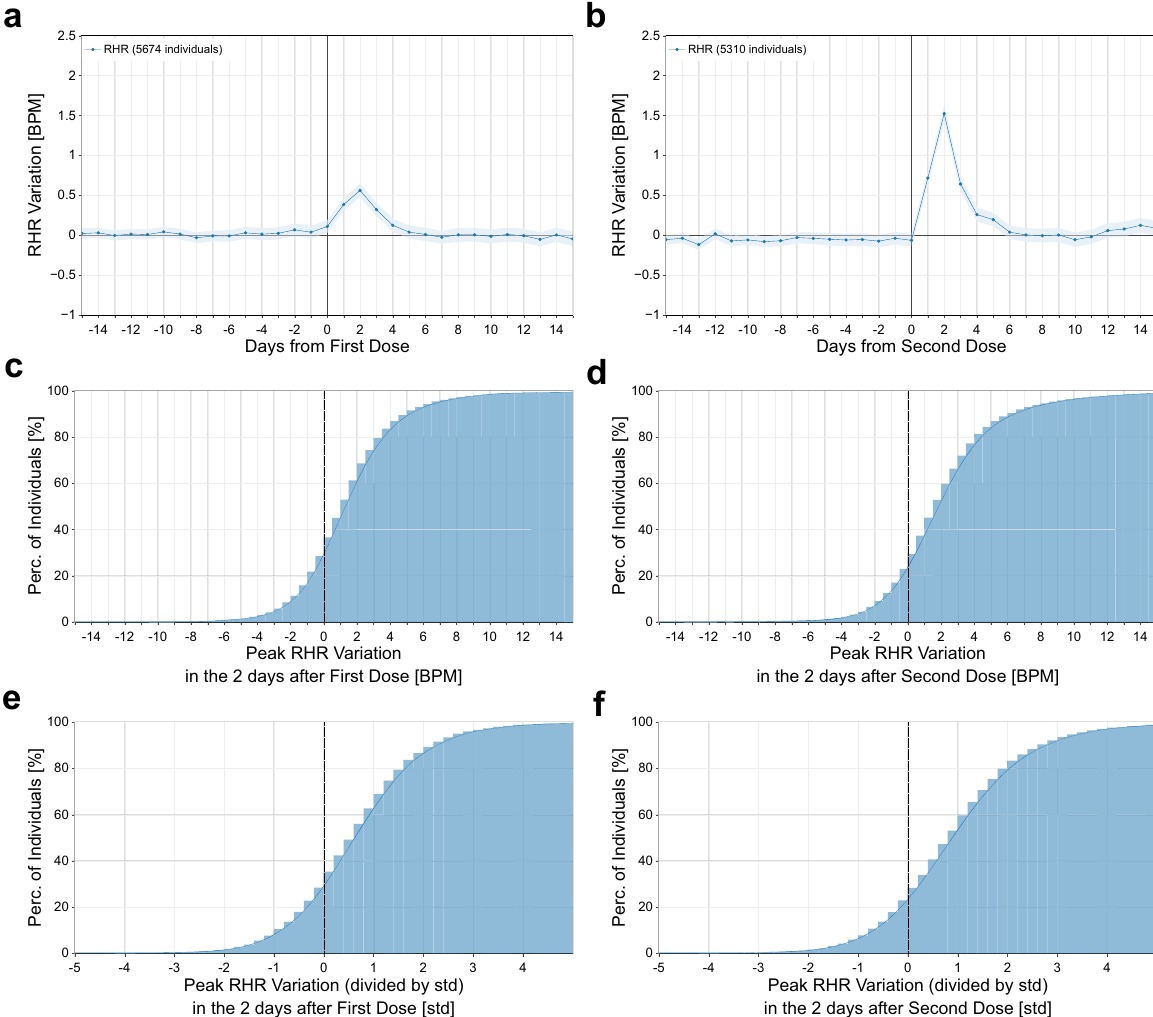
Fig. 1 Peak resting heart rate changes post vaccination. Mean and 95% con fi dence interval of the absolute individual changes in resting heart rate (in BPM) with respect to the individual baseline around the date of vaccination (day 0), for the fi rst dose of the vaccine ( a ) and for the second dose ( b ). The cumulative distribution of the maximal variation in resting heart rate in the 2 days after the fi rst ( c ) and second ( d ) vaccine dose, and the variation normalized by the individual standard deviation ( e , f